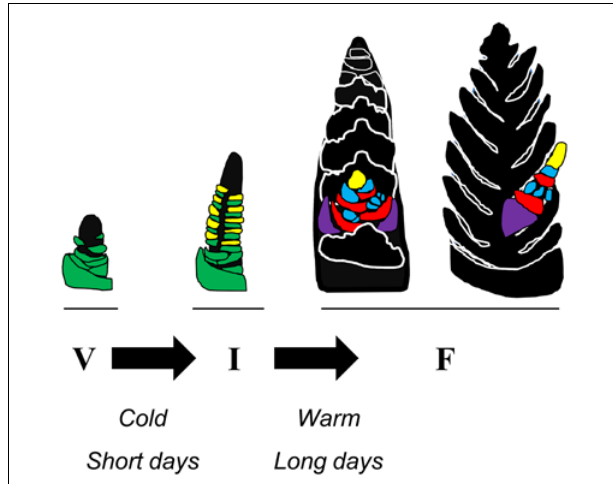
FIGURE 1 | Schematic representation of how seasonal conditions influence the developmental transitions of wheat. At the beginning of the crop life cycle there is a vegetative meristem at the tip of the shoot apex of the main tiller. Leaf primordia (green) develop below the meristem. During winter short days or prolonged cold can promote the transition to reproductive development.This allows inflorescence initiation (I) to occur. The shoot apex elongates and inflorescence primordia (yellow) appear above each of the leaf primordia. During subsequent stages of inflorescence development the lateral inflorescence meristems develop into branches (the spikelets) upon which florets develop, whereas development of leaf primordia ceases. During spring long days and high temperatures can accelerate inflorescence development.Two orientations of the developing inflorescence are represented (F, floral development) with a single spikelet highlighted and the rest of the spike shown in silhouette. Each spikelet has 2 glumes (purple) and then a series of florets at an early stage of development.The lemma primordia (red) and floral organ primordia (anther primordia, blue) are shown, along with the lateral inflorescence meristem at the end of the spikelet (yellow). Each unit of lemma and floral organ primordia will differentiate into a